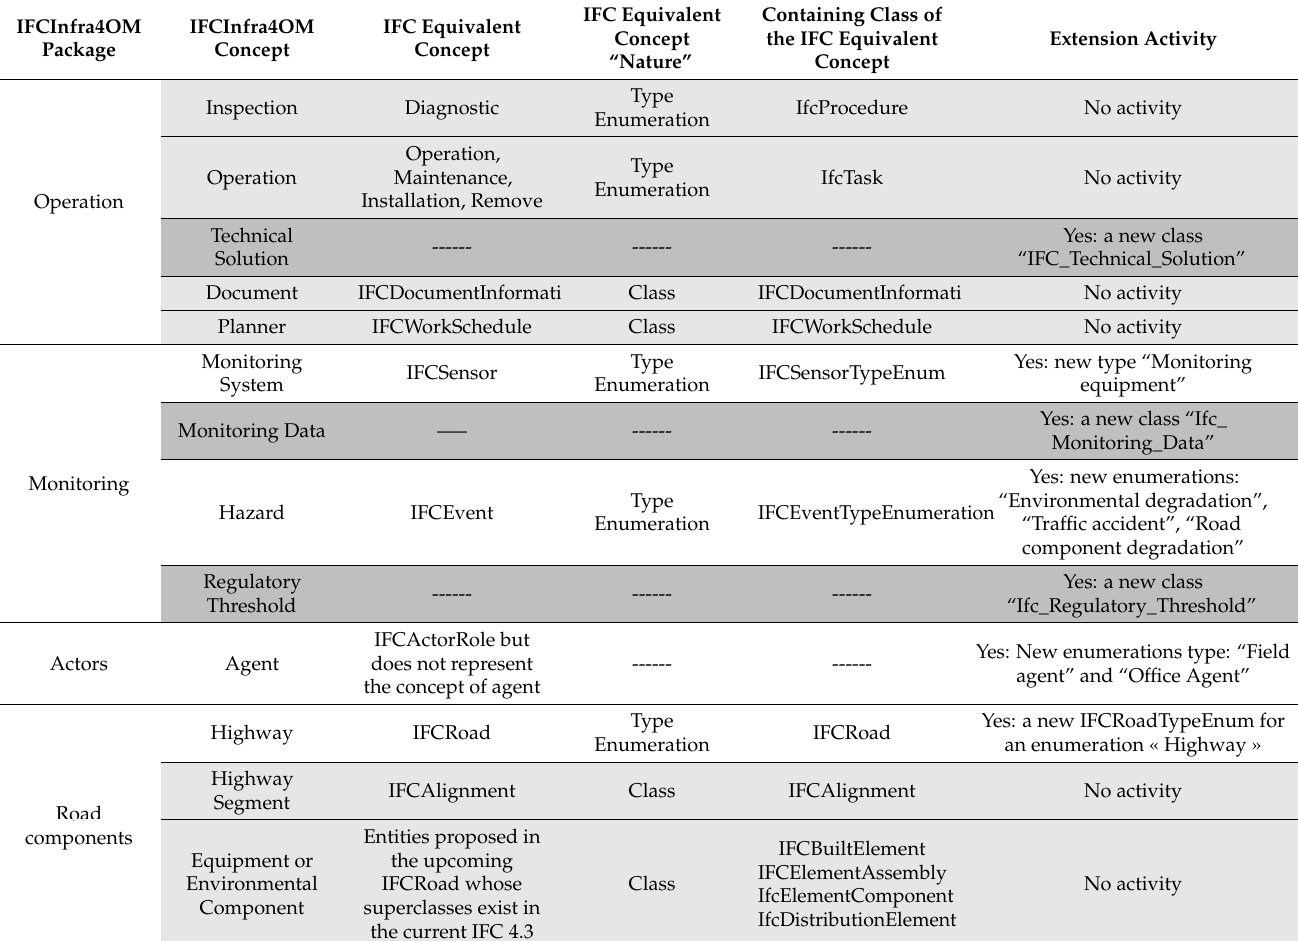
Table 6. IFC extension by IFCInfra4OM ontology mechanisms: entity level.